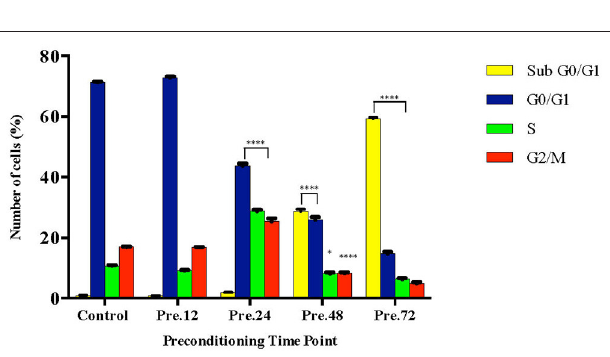
FIGURE 9 | Quantitative analysis of cell cycle distribution analysis in LPS-preconditioned cells by using flow cytometry. The differentiated PC12 cells were exposed to 3 µ g/mL LPS for 12, 24, 48, and 72h. Cell cycle phase distribution based on the DNA content was determined by cell cycle assay. Bars represent mean data ± S.E.M from three independent experiments. Data were analyzed using one-way ANOVA, followed by a Bonferroni post-hoc test. Percentage of LPS-stimulated cells was compared to the control. * p < 0.05, **** p < 0.0001 considered to be statistically